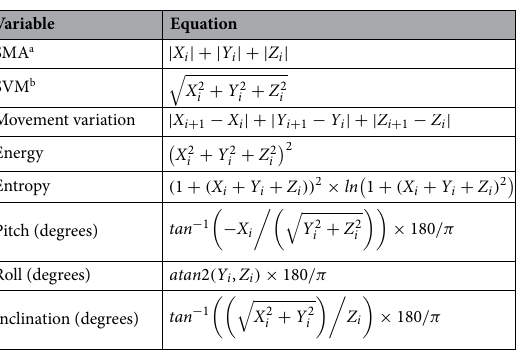
Table 4. Calculation of variables from the sensor axis records. a SMA, signal magnitude area; b SVM, signal vector magnitude (Alvarenga et al. 4